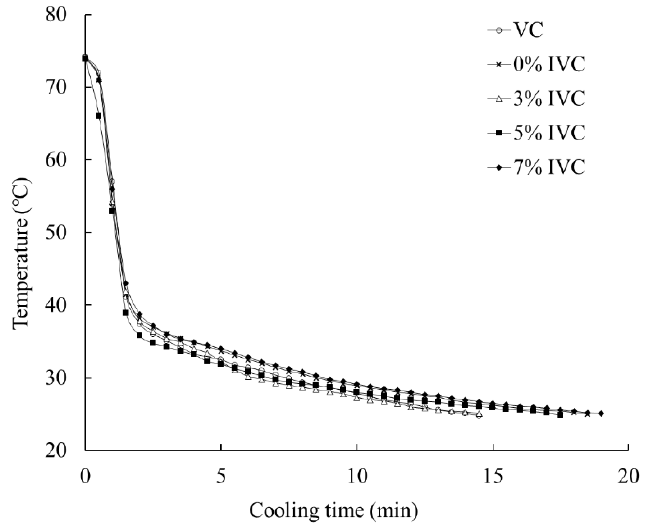
Figure 2. Core temperature curves for chicken drumsticks immersed in solutions with different salt ion concentrations. VC: vacuum cooling; IVC: immersion vacuum cooling; 0%, 3%, 5%, and 7%: salt ion concentrations.